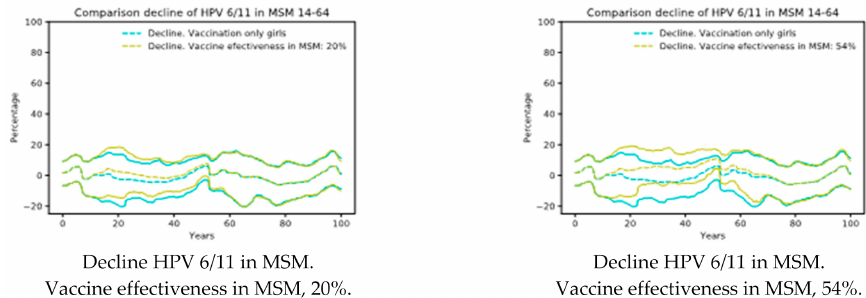
Figure 2. Scenario 3: Vaccination girls’ coverage 70% and 20% of MSM 18 to 45 years vaccinated. Decline of HPV 6/11 in MSM depending on the vaccine effectiveness [39]. Note that there are small effects in the decline. MSM: men who have sex with men.